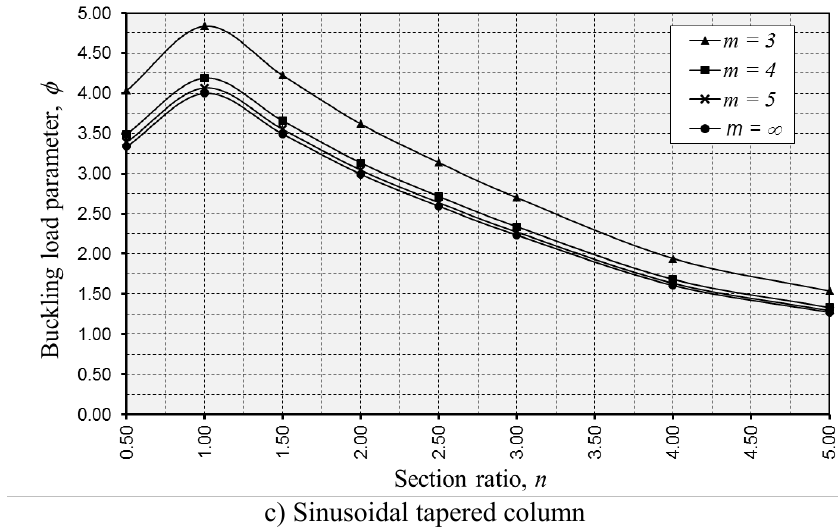
Fig. 5. Buckling load parameter of tapered columns with clamped